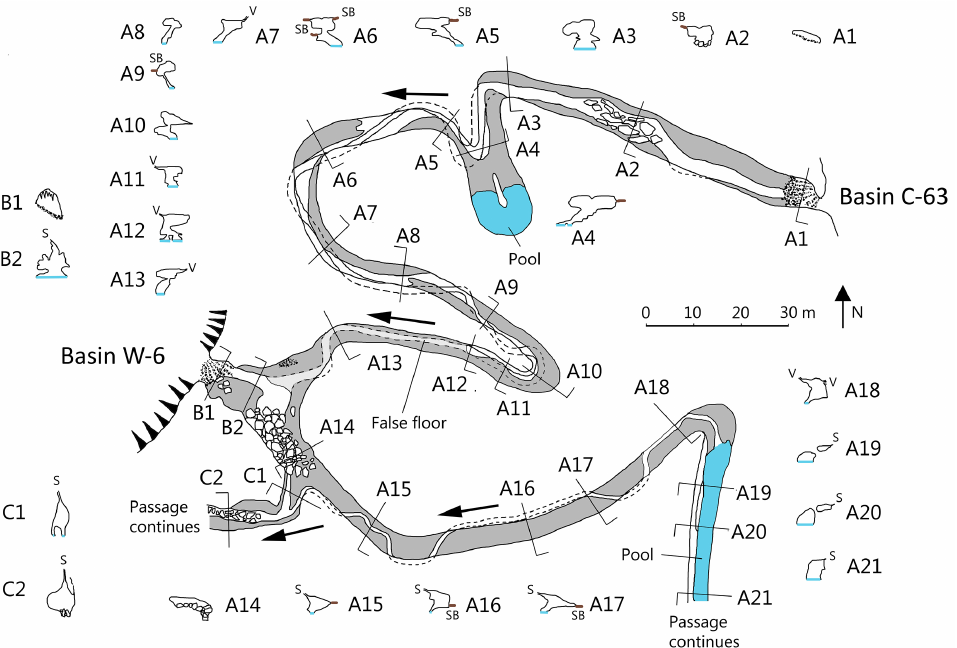
Figure 4. Plan and passage cross sections of englacial conduit NG-04. SB: sediment band; S: suture; V: voids. Dark-grey-filled and white- filled areas within the cave plan indicate the floors of the upper and lower levels, respectively. Pale grey and dashed lines are used where the lower level is occluded by higher false floors. Standing water on the cave floor is shown in blue. For location, see Fig.